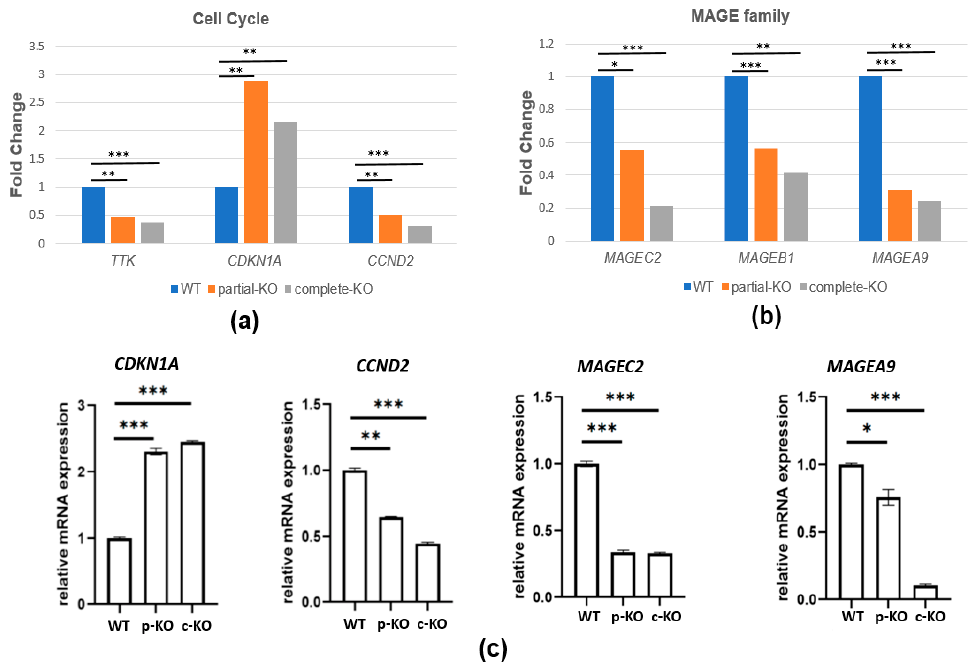
Figure 4. TRIM28 regulates cell proliferation-related gene expression. The transcripts from WT, TRIM28 partial-KO (p-KO), and complete-KO (c-KO) K562 cells were performed in a human microarray Clariom D assay. ( a , b ) The expression levels of cell cycle and MAGE family genes are dependent on TRIM28 dosages. ( c ) RT-qPCR analysis of CDKN1A , CCND2 , MAGEC2, and MAGEA9 expression. * p < 0.05, ** p < 0.01, and *** p < 0.001.